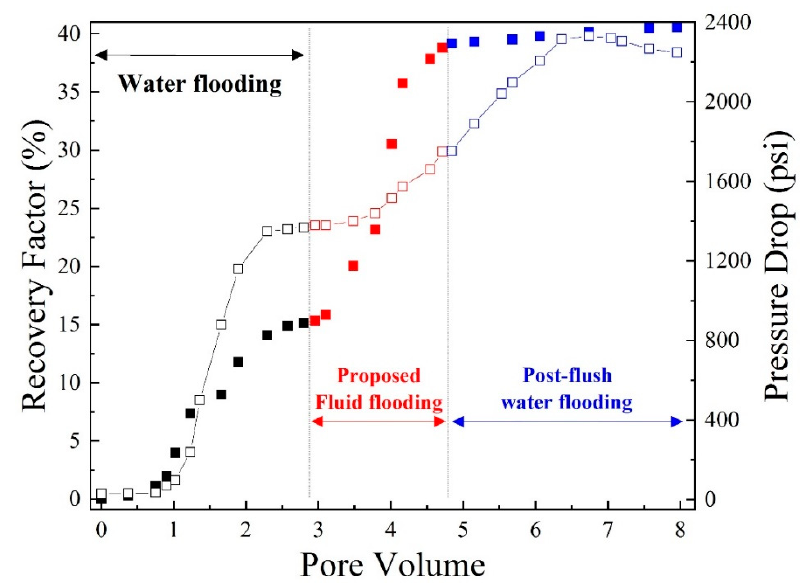
Figure 10. Pressure drop (open) and recovery factor (closed) vs. pore volume in Fn-700 core sample (1000 ppm polymer at high salinity).